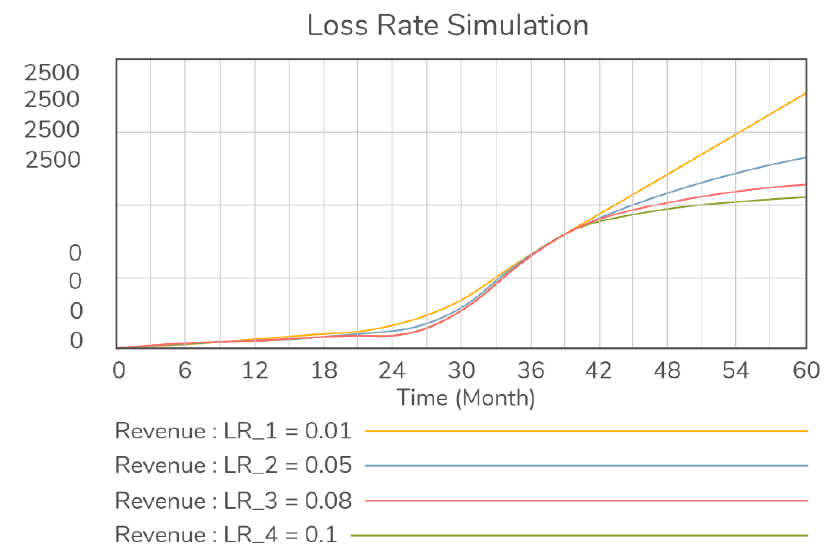
Figure 8. The OI simulation with four different Loss Rate (LR).